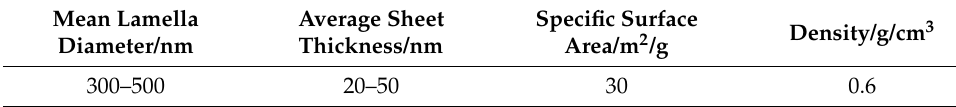
Table 2. Physical properties of NMK.